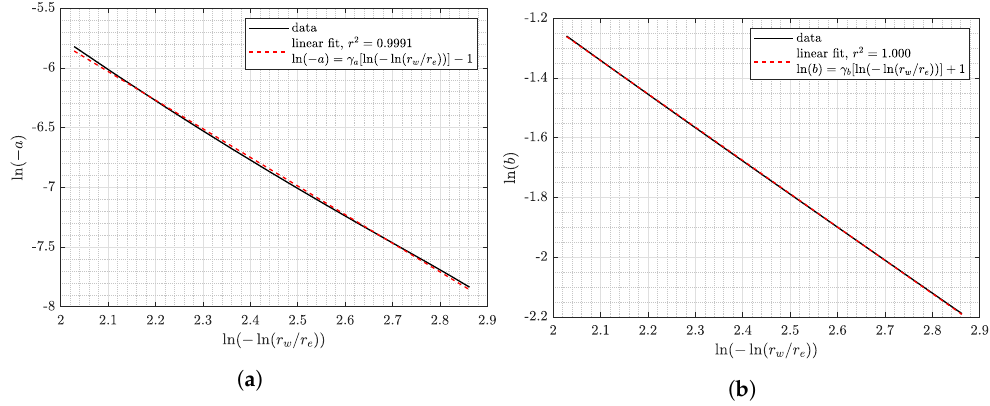
Figure A8. Linear relationship between ( a ) ln ( − a ) and ( b ) ln ( b ) versus ln ( ln ( r w / r e ))